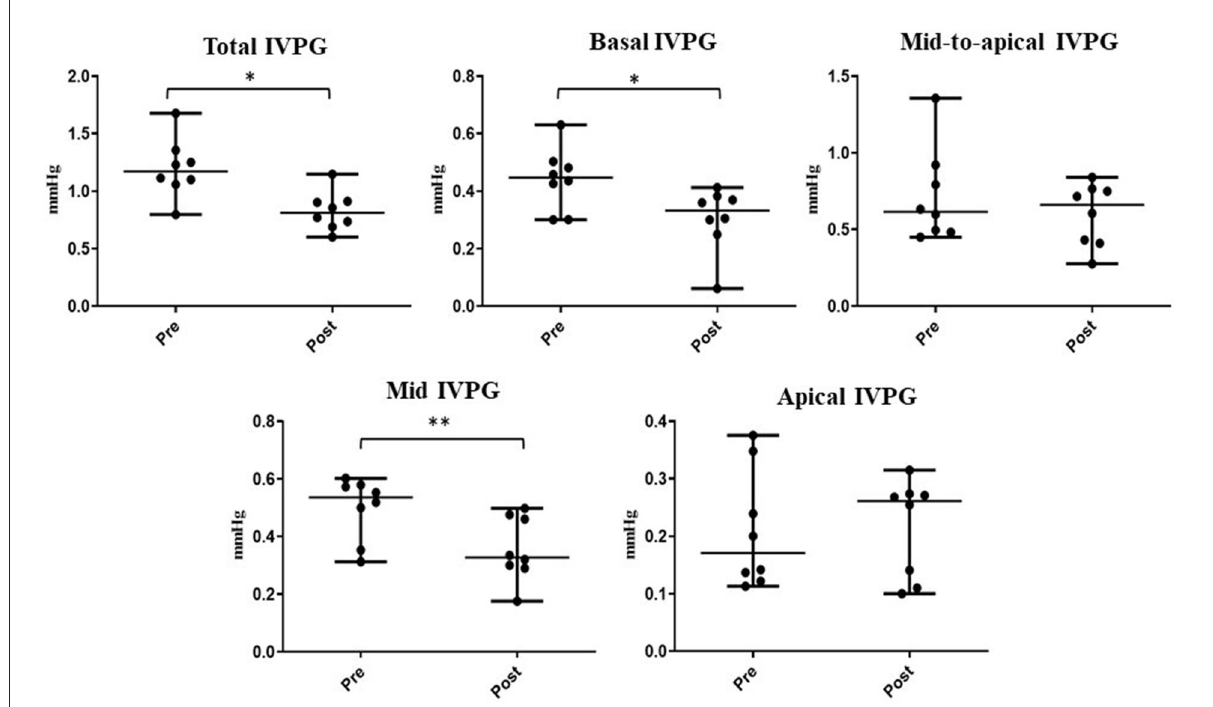
FIGURE5 Changes in IVPG indices before and after sedation with xylazine in goats ( n = 8). Plots showing the median (central horizontal line) and range (upper and lower lines). * p < 0.05, ** p <